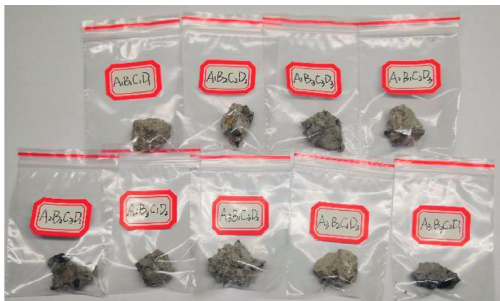
Figure 3: Nine groups of RCASCC were sampled for MIP.